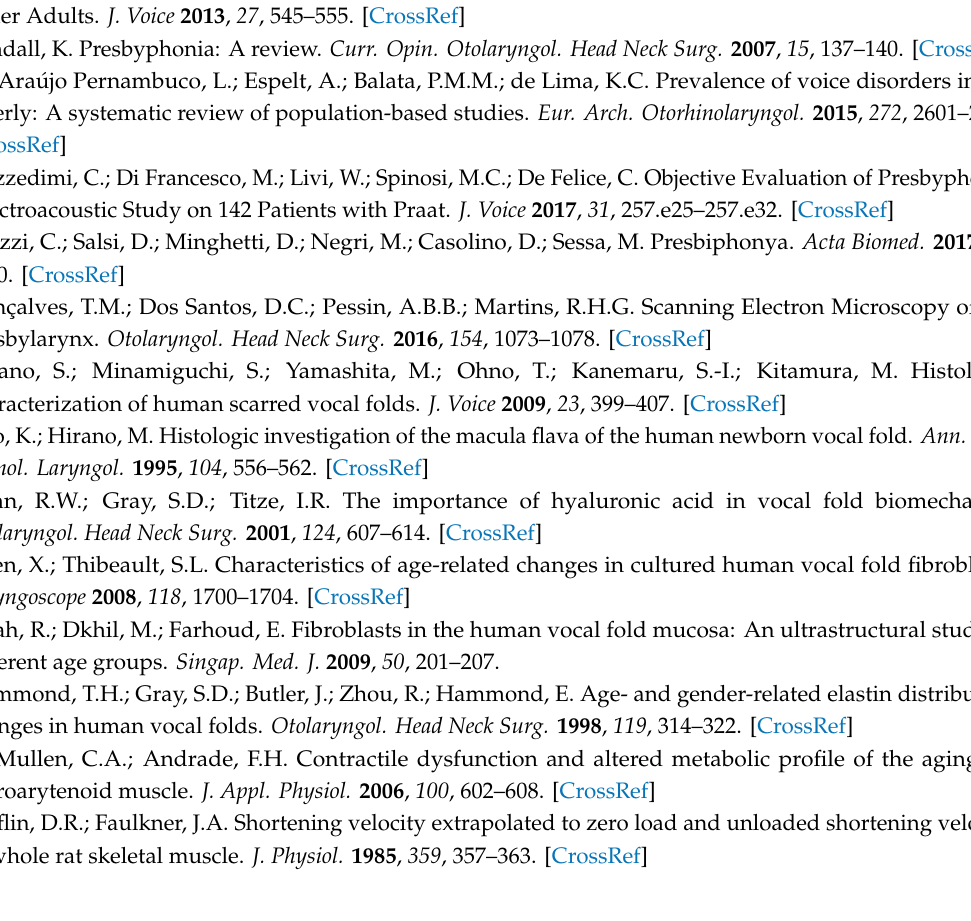
Table S1: Demographic and anthropometric characteristics of younger adults. Table S2: Demographic and anthropometric characteristics of older adults. Table S3. Ranking of the first 20 features (functionals applied to low-level descriptors) extracted using OpenSMILE and selected using CAE for the comparison between YA and OA, during the emission of the vowel and the sentence. Each feature is identified by four items: (1) family of low-level descriptor (LLD), (2) LLD, (3) functional used to calculate that specific feature and, (4) the value of relevance calculated through CAE